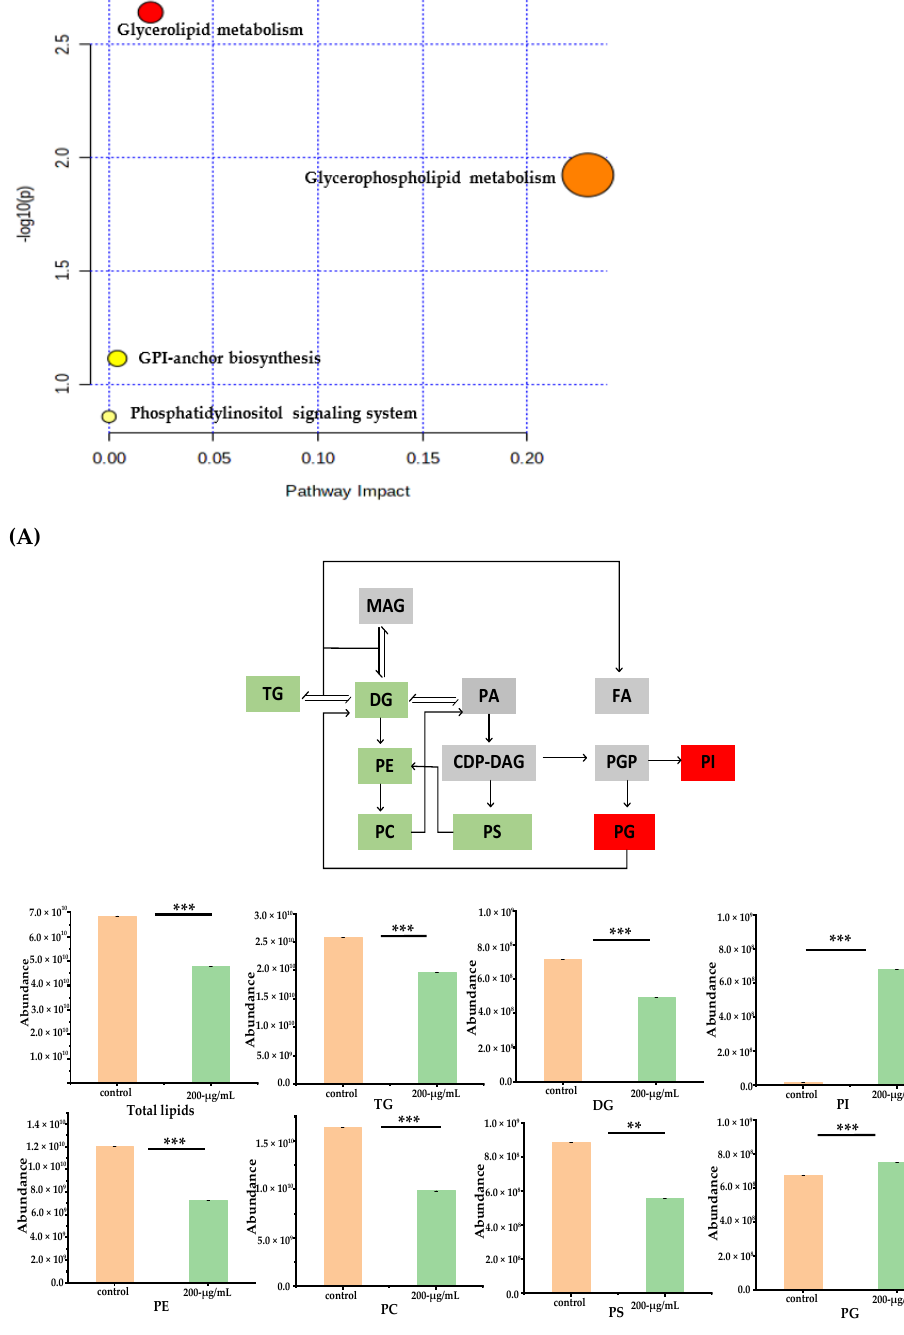
Figure 7. ( A ) Pathway analysis overview depicting altered metabolic pathways in A. flavus from the 200- μg/mL CV-treated group and the control. ( B ) Biosynthesis of glycerolipids and phospholipids [35] in A. flavus [36]. The red boxes showed upregulated lipids of mycelium treated with 200- μg/mL CV vs. the control, the green boxes indicated downregulated lipids and the gray boxes were lipids undetected or not changed significantly in the pathways. The glycerolipids included monoacylglycerol (MAG), DG and TG, whereas the phospholipids included PA, PC, PE, PS, PI and PG. CDP-DAG: CDP-diacylglycerol, PGP: proline-glycine-proline and FA: fatty acids. The bar groups indicated the abundance of lipids. Data were presented as the mean ± standard error of the mean ( n = 6). ** and *** indicated p < 0.01 and 0.001, respectively. Table 2. Results from the ingenuity pathway analysis with Metaboanalyst in the 200- μg/mL group vs. control group.